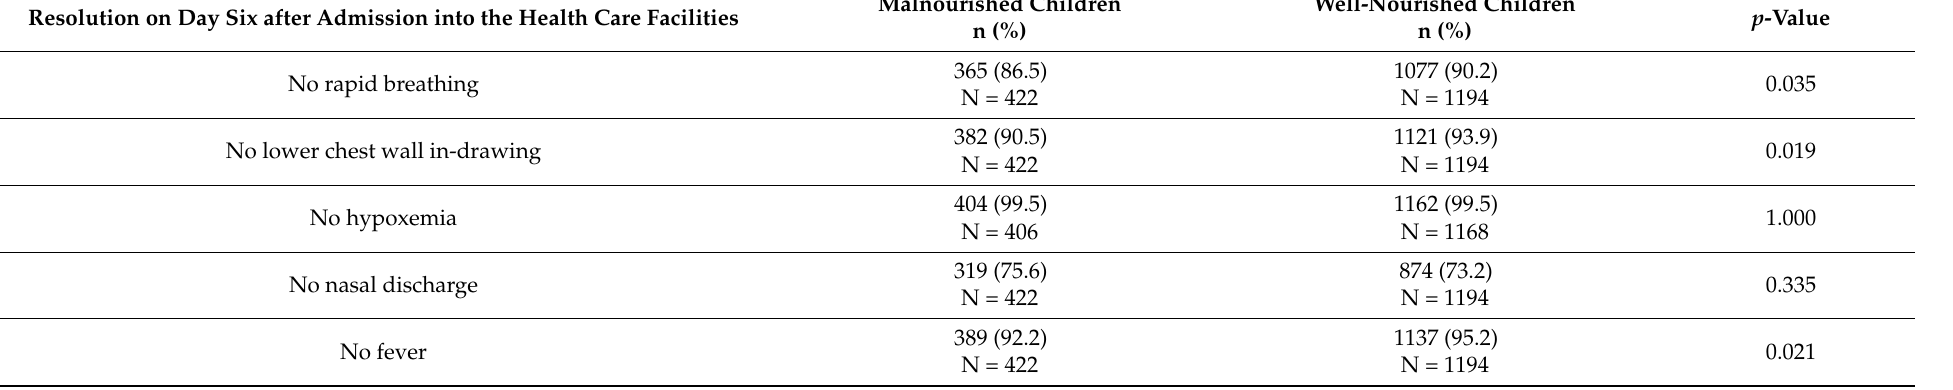
Table 2. The resolution of clinical features of severe pneumonia in malnourished children compared to well-nourished children on day six after admission.